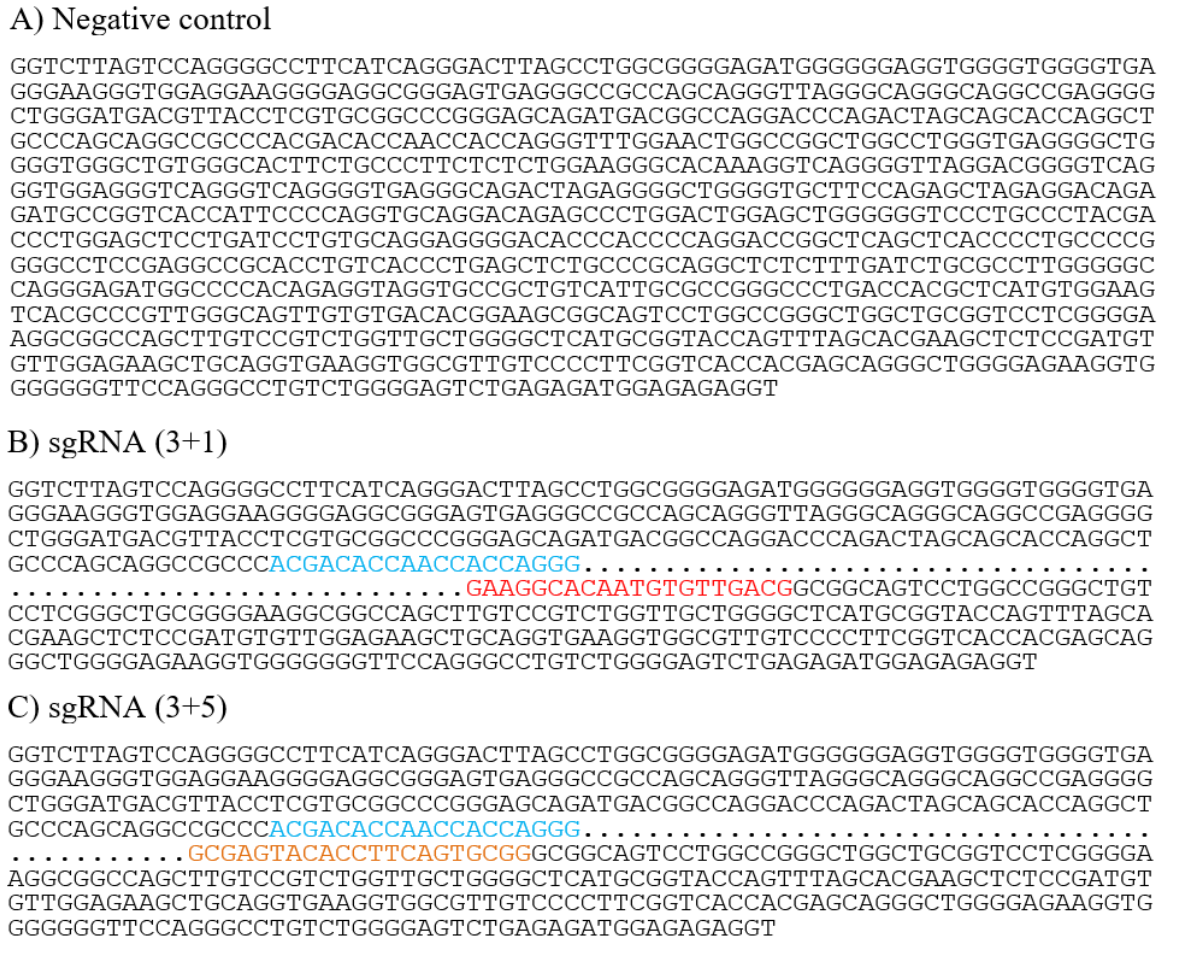
Fig. 4. PCR product sequencing: A) Negative control without transfection; B) Indel produced by sgRNA (3+1) (lipofectamine); C) Indel produced by sgRNA (3+5)